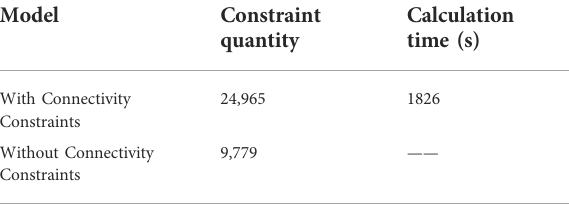
TABLE 6 Number of constraints and computing time for the model with and without connectivity constraints.